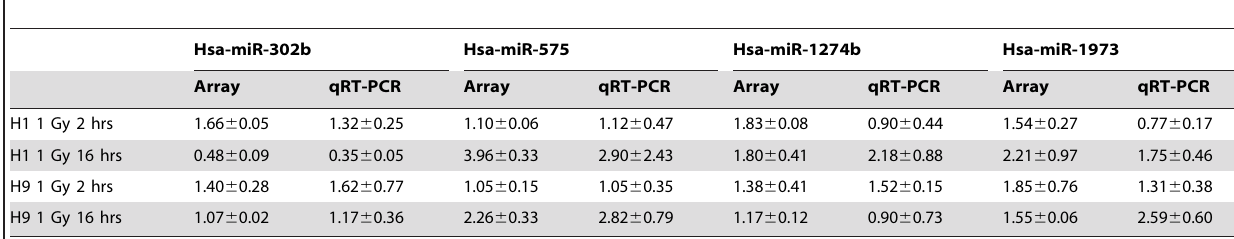
Table 8. Verification of miRNA microarray data with Taqman qRT-PCR. Shown are means and standard errors for corresponding values obtained by two